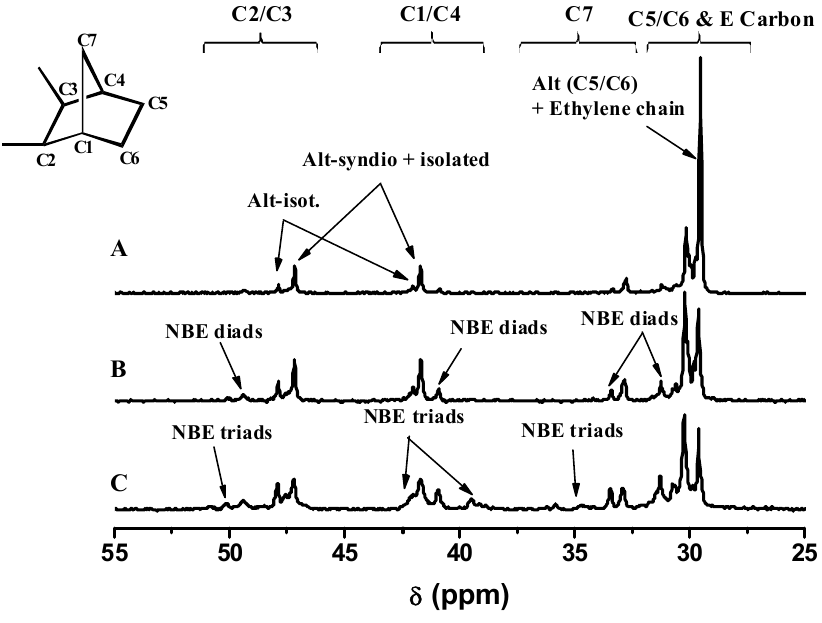
Figure 3. 13 C NMR spectra of E/NBE copolymer with different NBE incorporations